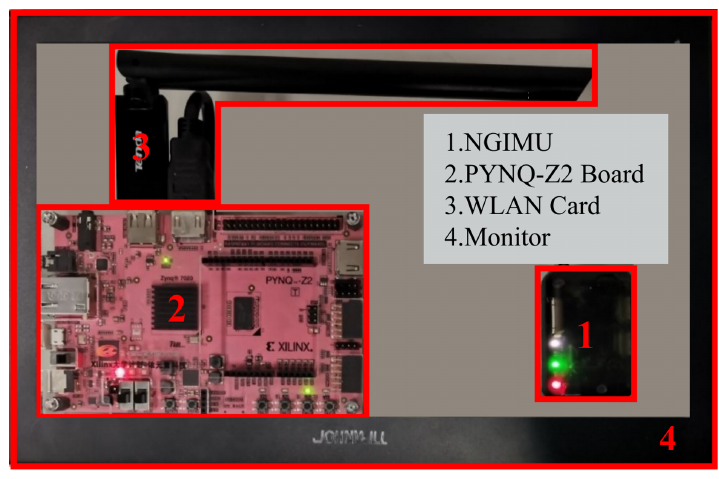
Figure 8. Hardware platform.